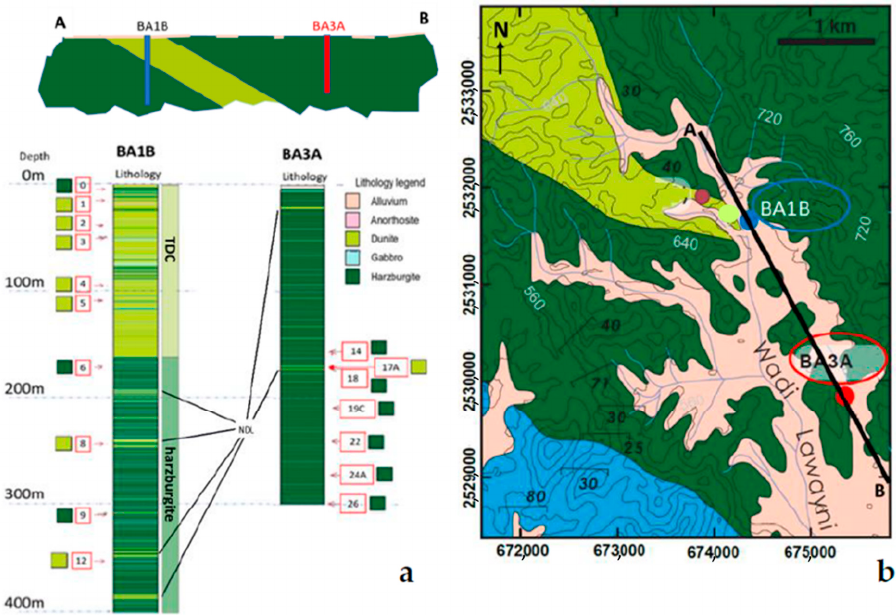
Figure 2. ( a ) Modelled geological section along the black line AB of Figure 2b, with the position of BA1B and BA3A Holes, their respective stratigraphic columns with samples position and relative thin section number in the red boxes. ( b ) Geological map of the drilling area (modified by after [28]). For the samples analysed in Austria, raw data show correct proportion of cations as atoms per formula units (a.p.f.u.), in spite of the low total wt. % (from less to much less of 100 wt. %). For this reason, recalculation of the structured formula performed after normalizing the oxide wt. % to 100, as shown in the Supplementary Materials (Tables